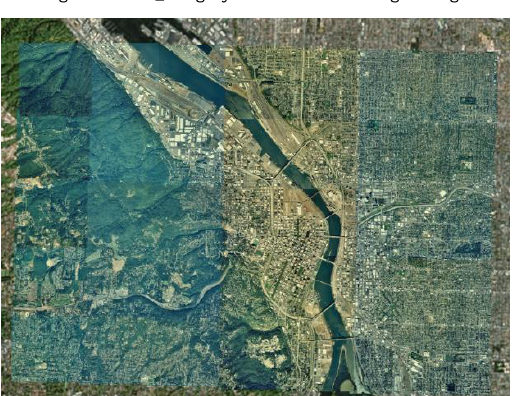
Fig.4.1 World_Imagery used as external target image.